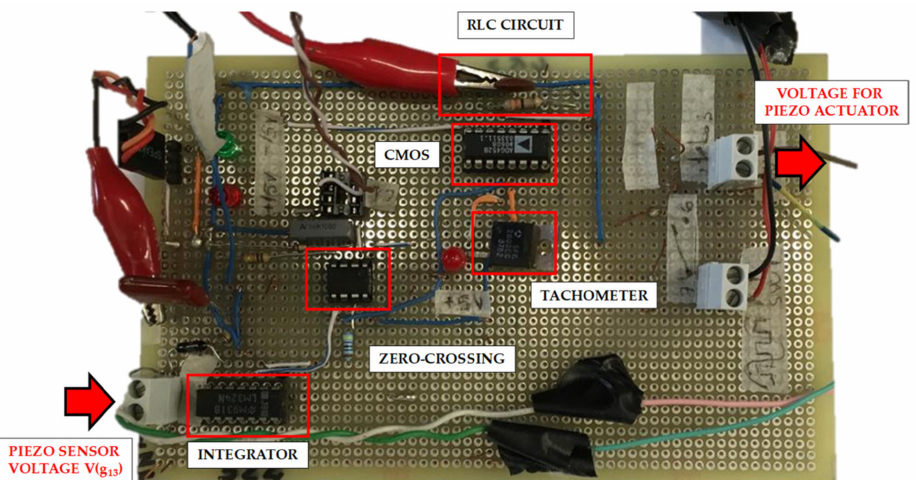
Figure 11. SISO control